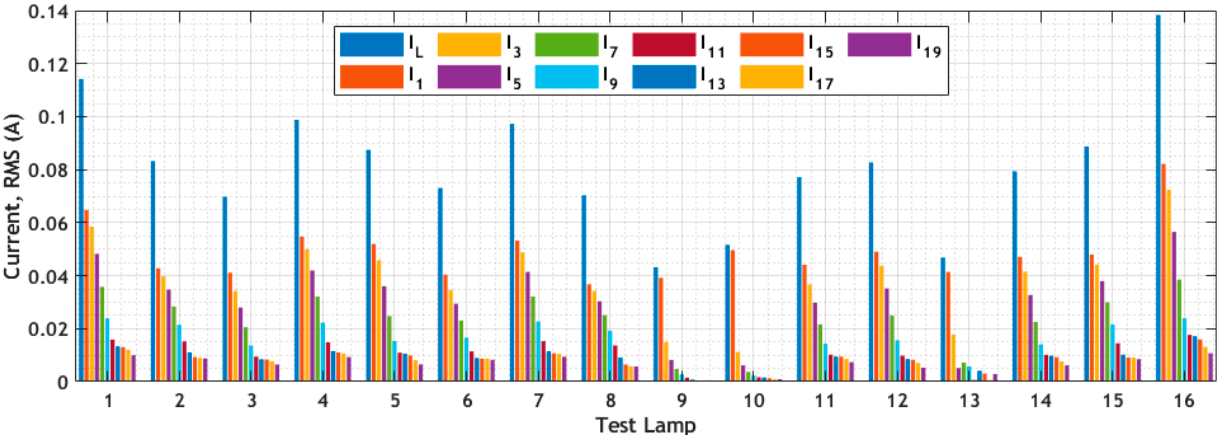
Figure 3. Current harmonics in lamps. Table 2. Measured harmonics’ current characteristics for individual lamps.